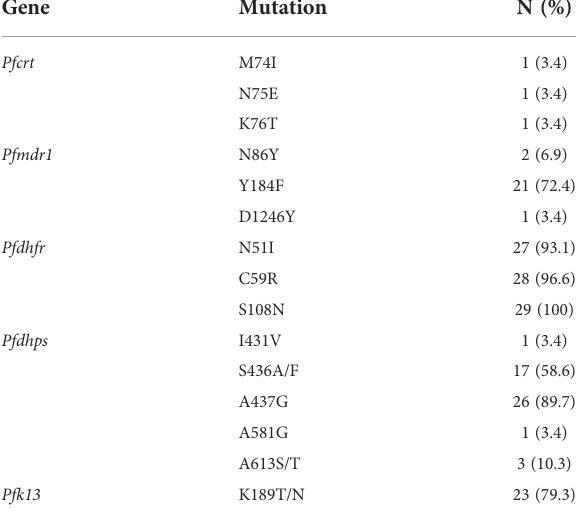
TABLE 2 The prevalence of mutations (%) in genes associated with drug resistance. Gene